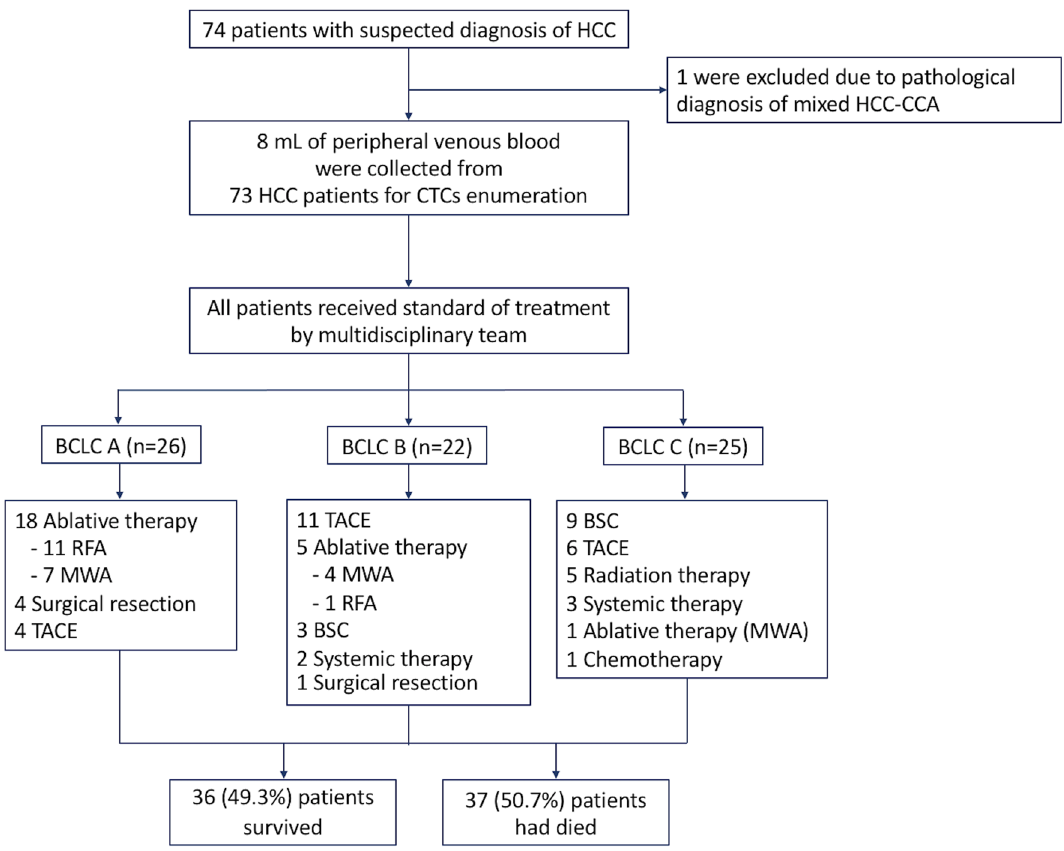
Figure 1. Flow diagram of patient enrollment. Abbreviations: BCLC; Barcelona clinic liver cancer. BSC; best supportive care. CTCs; circulating tumor cells. HCC-CCA; hepato-cholangiocarcinoma. HCC; hepatocellular carcinoma. MWA; microwave ablation. RFA; radiofrequency ablation. TACE; transarterial